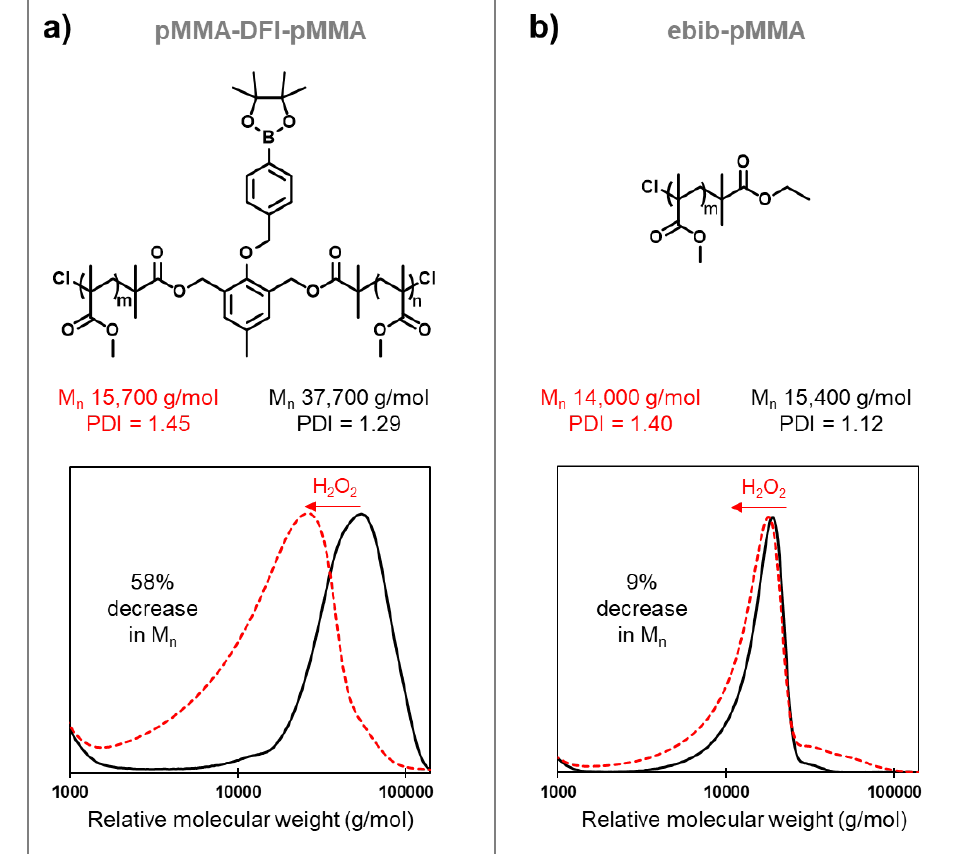
Figure 5. Molecular weights and polydispersity indexes for poly(methyl methacrylate) synthesized by ATRP using two different initiators before and after oxidative degradation experiments: ( a ) pMMA-DFI-pMMA; ( b ) ebib-pMMA. Plots of relative molecular weight distributions were obtained versus poly(methyl methacrylate) standards in tetrahydrofuran.